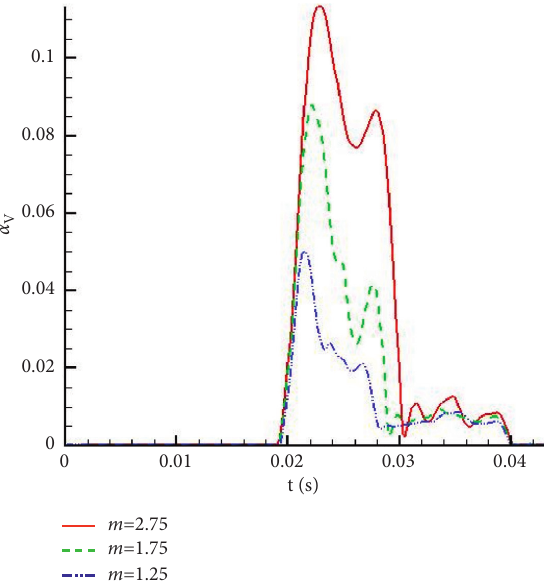
Figure 14: Change curve of α m .